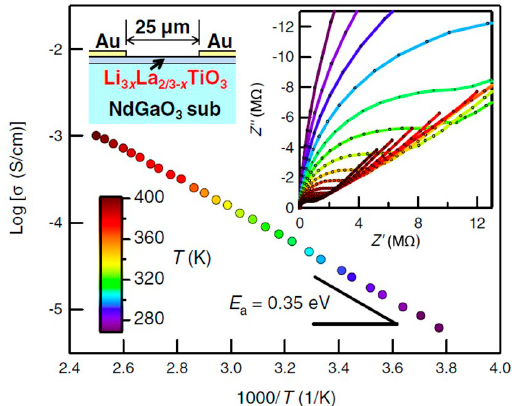
Figure 14. Temperature of the in-plane ionic for conductivity epitaxial Li 0.33 La 0.56 TiO 3 solid electrolyte thin films (36-nm tick) deposited on NdGaO 3 (110) by PLD at T s higher than 900 °C under P O ₂ = 5 Pa. (Reproduced with permission from [272]. Copyright 2012 Elsevier).